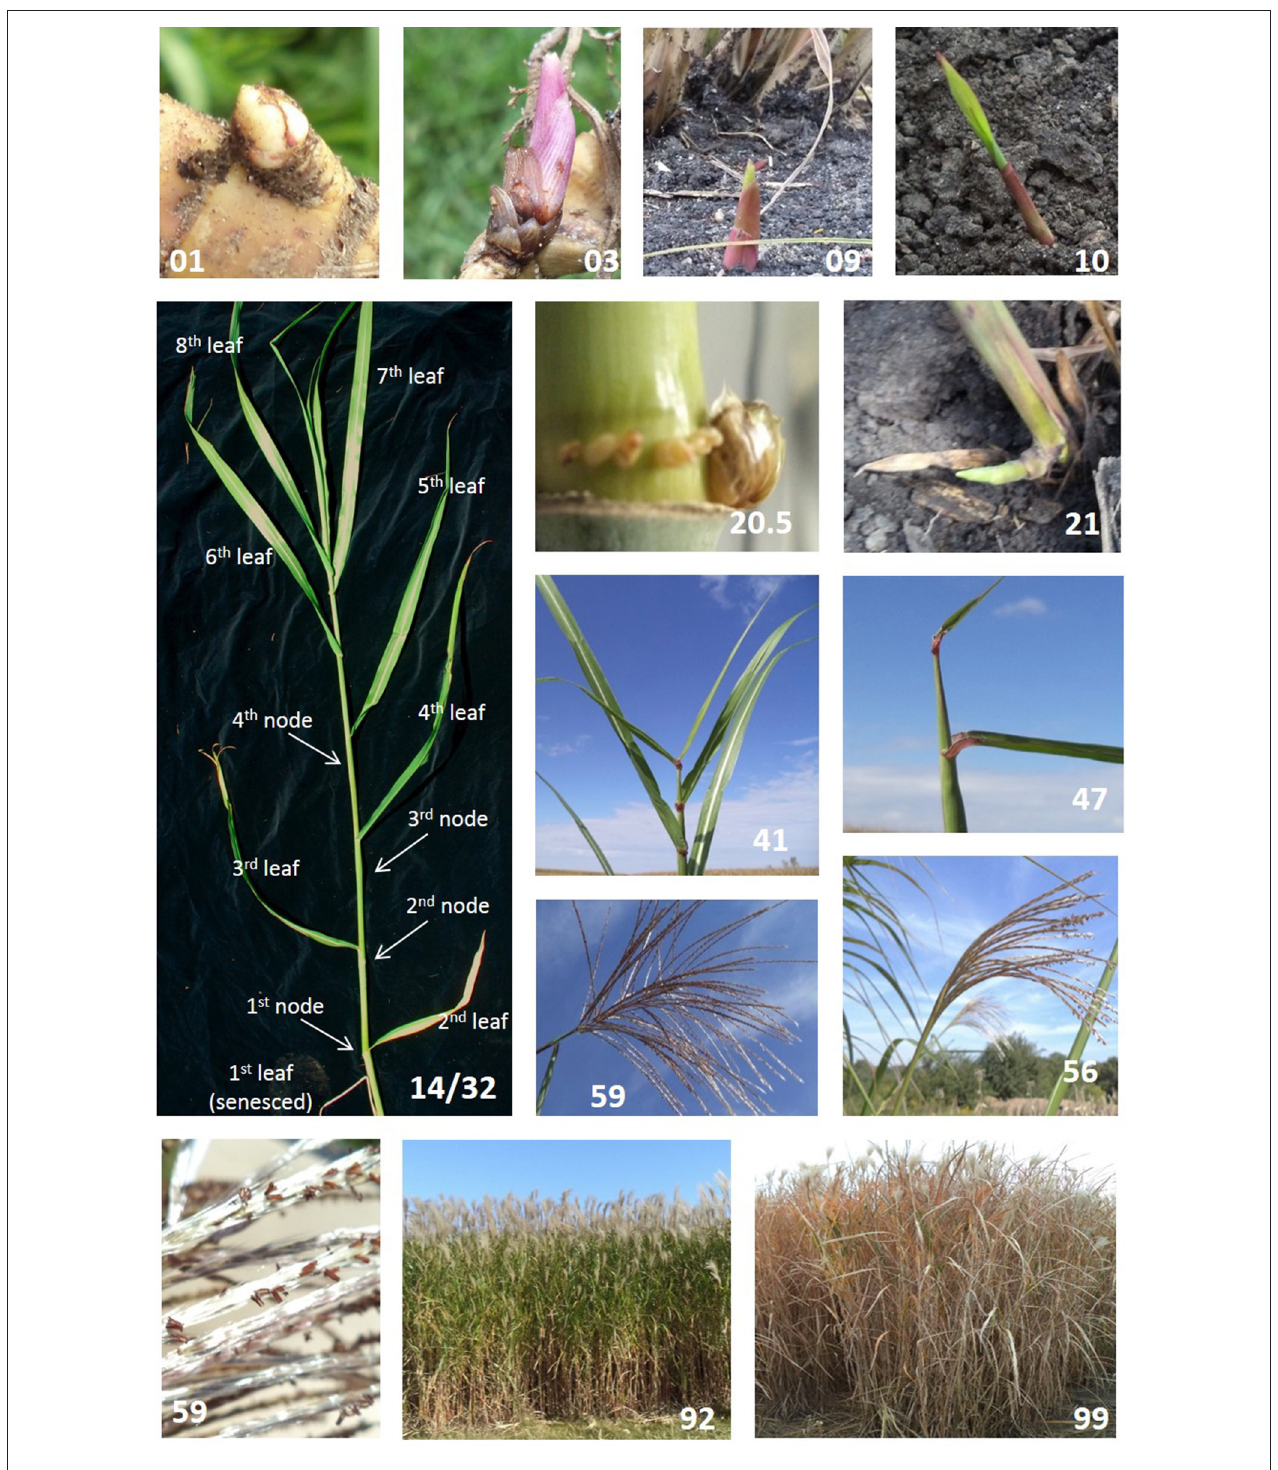
FIGURE 1 | Select Miscanthus × giganteus morphological development stages as described using the BBCH scale ( Table 2 ). Each picture highlights a single developmental stage: 01 beginning of bud swelling; 03 end of bud swelling; 09 emergence through soil surface; 10 first visible leaf lamina; 14/32 stem with eight fully expanded leaves (14) and 4 nodes (32); 20.5 swollen axillary bud ( ∼ 8–10mm); 21 one tiller on main shoot; 41 flag leaf is fully expanded; 47 inflorescence occupies 75% of flag leaf sheath; 56 inflorescence lower branches exposed; 59 inflorescence fully exposed and peduncle exposure; 59 showing anther details; 92 stems 20% senesced; 99 stems 90–100%